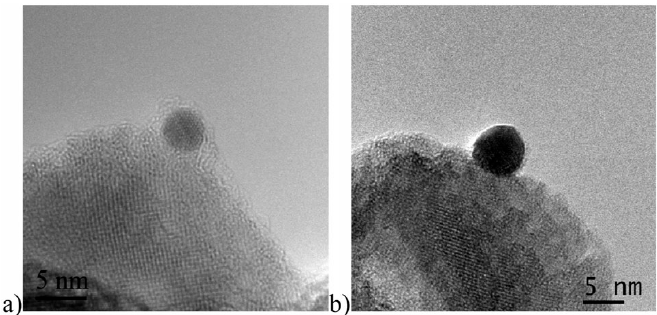
Figure 5. HRTEM images of Au NPs: ( a ) protected and ( b ) partially covered by PVA. Reproduced from ref. [65] with permission of The Royal Society of Chemistry.